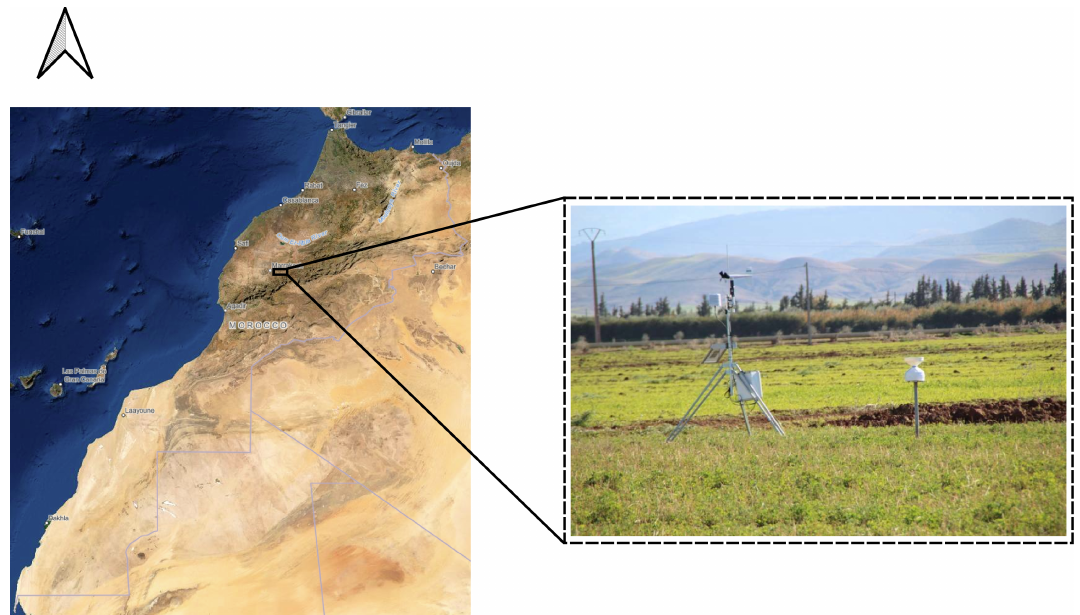
Figure 1. R3 district study area in Morocco and a Photo of the meteorological station